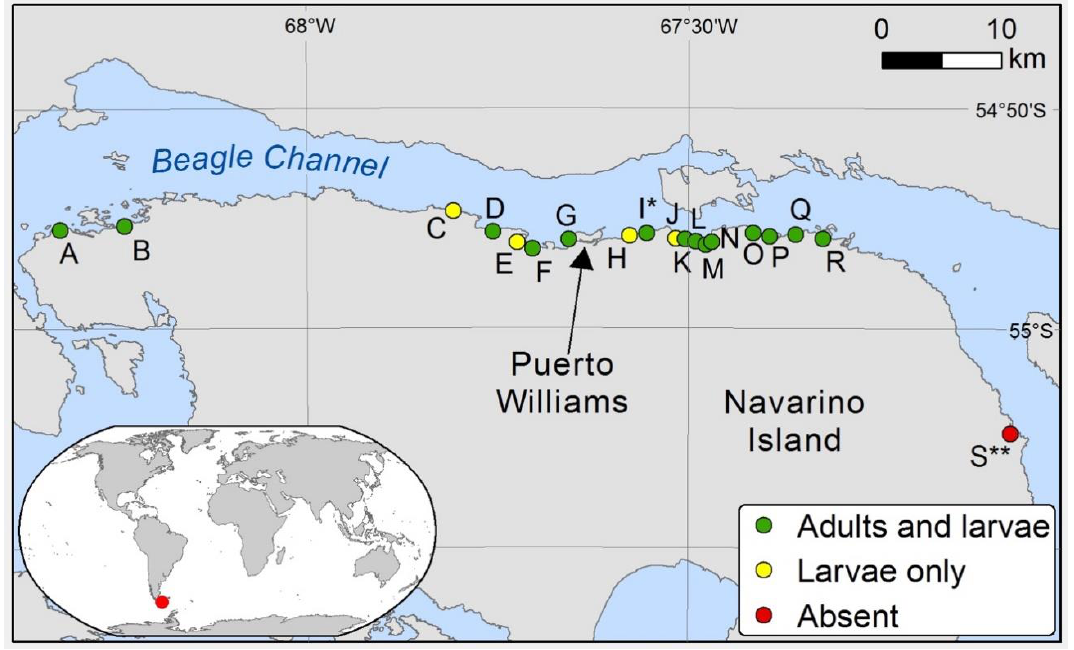
Figure 2. Navarino Island with the bays surveyed, colour-coded for presence/absence of adults and larvae of Telmatogeton magellanicus . (A, Puerto Navarino; B, Honda Bay; C, “Bahia Linda”; D, Chicha de Pera; E, “Second” Bay; F, Los Bronces; G, Róbalo Bay; H, Ukika; I, Puente Guanaco Bay; J, Punta Truco; K, “Seventh” Bay; L, Amarilla Bay; M, “Fifth” Bay; N, Corrales Bay; O, “King Penguin” Bay; P, “Third” Bay; Q, “Casita” Bay; R, Eugenia Bay; S, Puerto Toro) (* also Telmatogeton spp.; ** survey time was very